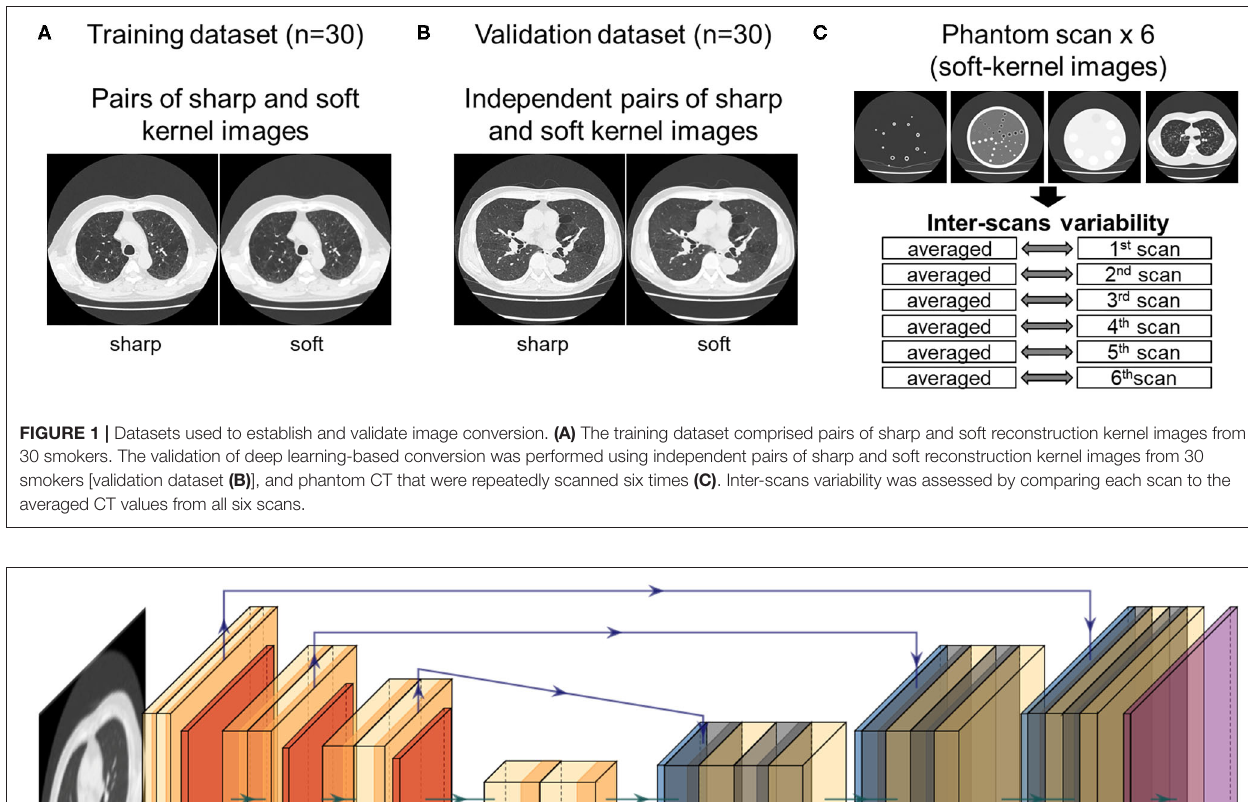
times to evaluate inter-scans variability using the same